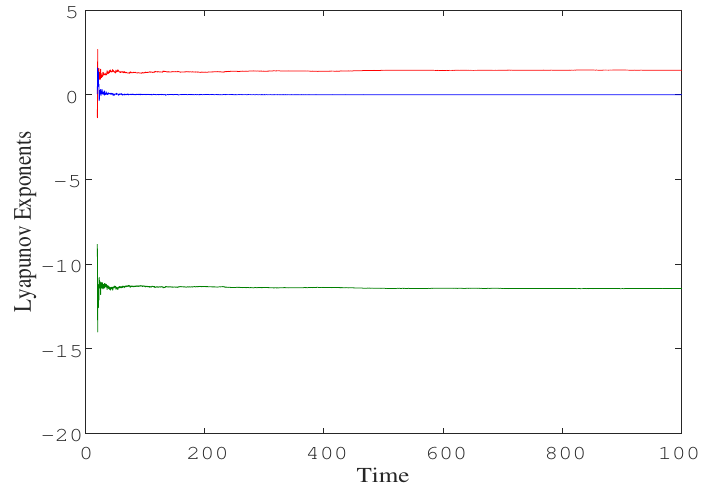
Figure 14. Lyapunov exponent spectrum of system (1) for ( a , b , c , k ) = ( 10,64,0,0 )